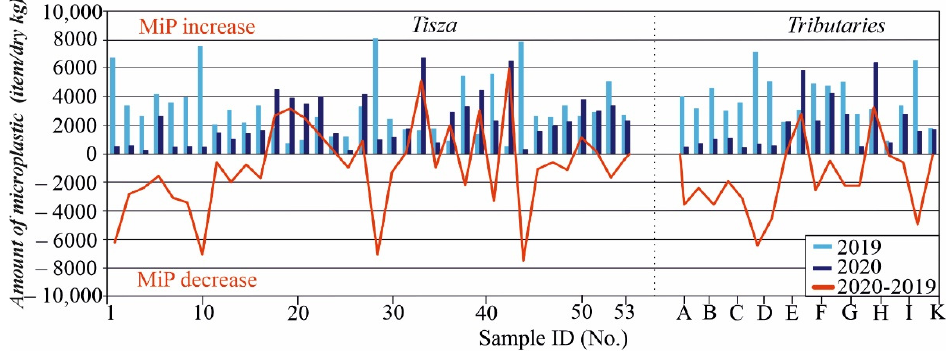
Figure 9. Differences in microplastic content (item/dry kg) of sediments collected at the same locations from coarse sediments in 2019 and 2020. (The capital letters refers to the sample ID of the tributaries, see Figure 1.)